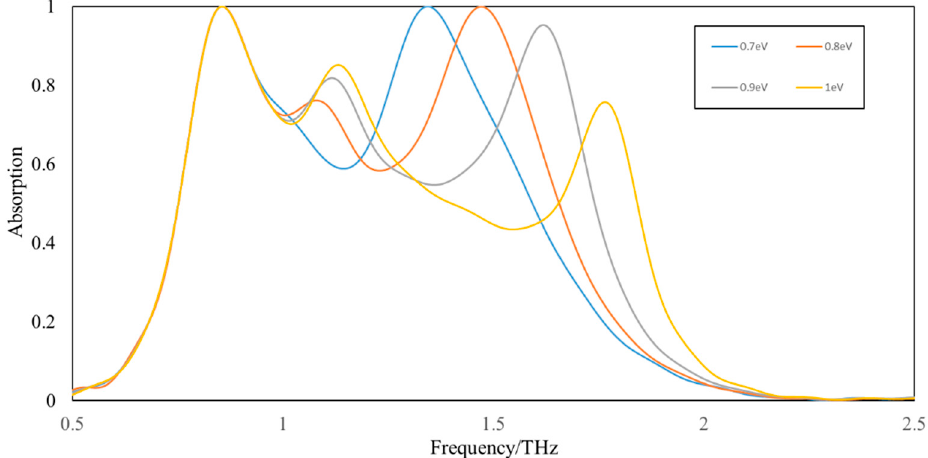
Figure 3. The simulated absorption spectrum of the absorber which the two rings’ Fermi level is constant (1.0 eV) and the smallest SGR’s Fermi level is varying from 0.7 eV to 1.0 eV. (blue line is 0.7 eV, red line is 0.8 eV, gray line is 0.9 eV, orange line is 1 eV).